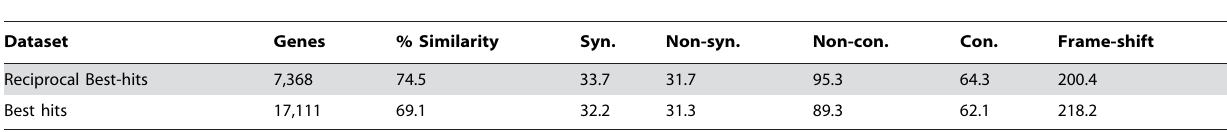
Table 1. ODDs scores associated with different types of variant pairs.